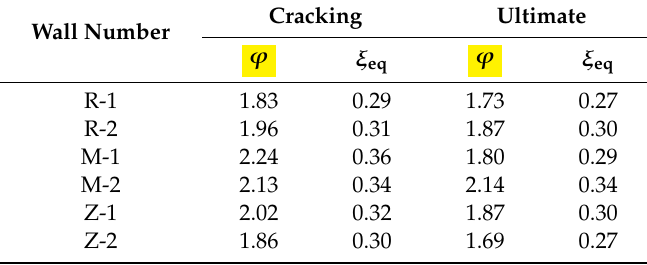
Table 3. Energy dissipation factor and equivalent viscous damping coe ffi cient of the walls. Wall